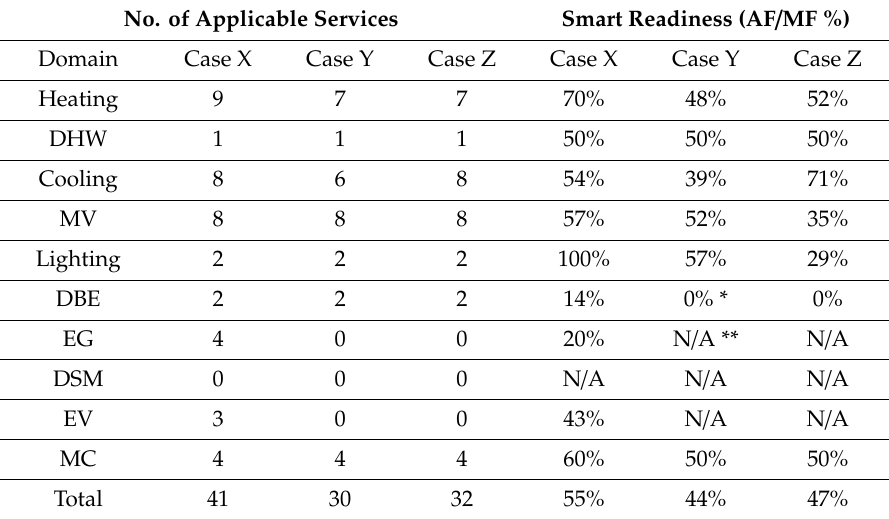
Table 14. The resulting level of smart readiness after triage process